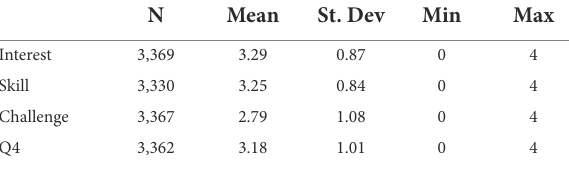
TABLE 1 Sample descriptives.